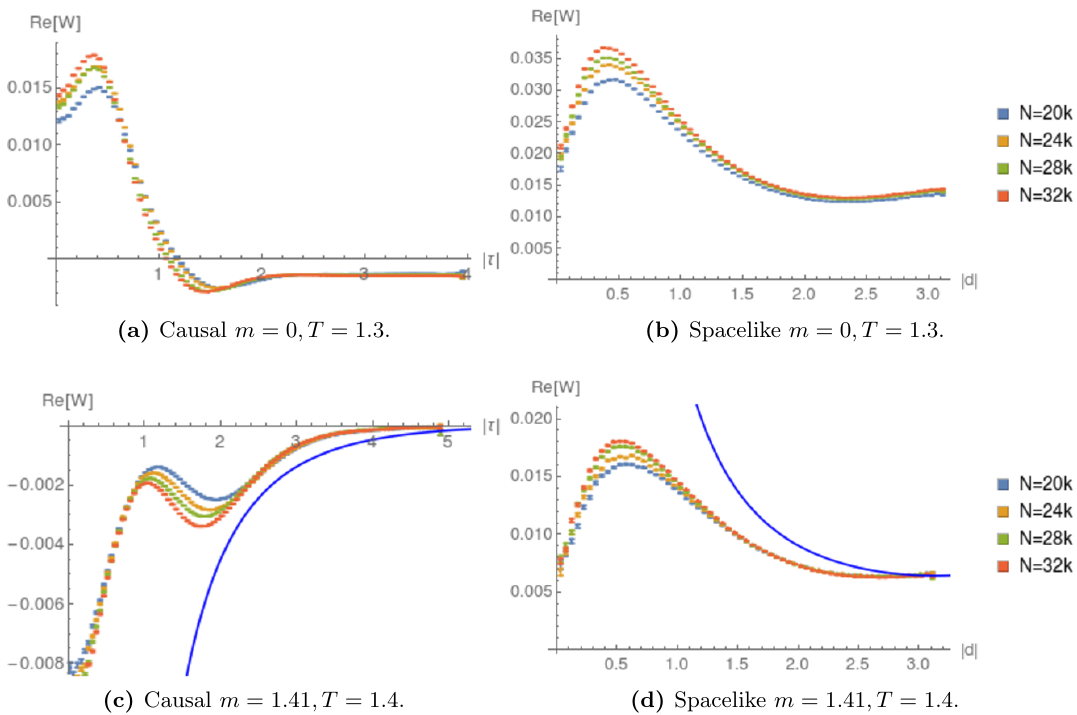
Figure 23. Re[ W ] vs. geodesic distance with varying density, in 4d de Sitter. The blue curve SJ shows the Euclidean two-point function as a